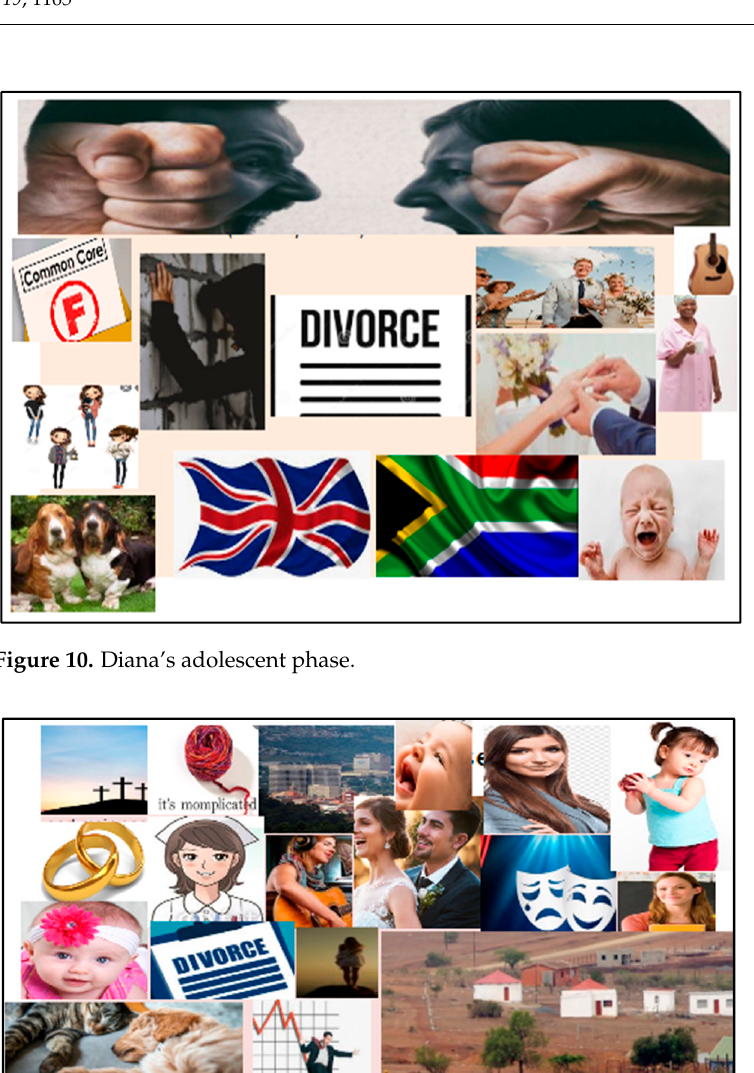
Figure 9. Diana’s timeline for middle childhood.